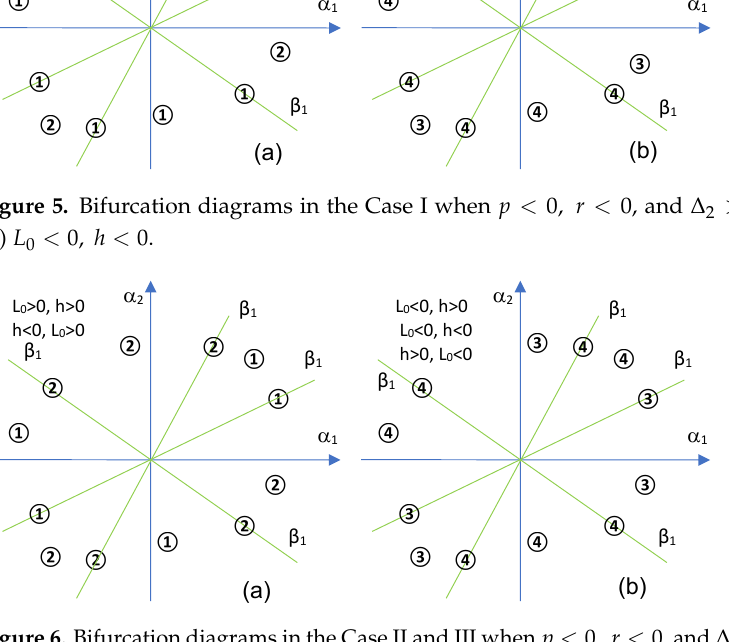
Figure 6. Bifurcation diagrams in the Case II and III when p < 0, r < 0, and ∆ 2 > 0: ( a ) L 0 > 0, h > 0 or h < 0, L 0 > 0; ( b ) L 0 < 0, h > 0 or L 0 < 0, h < 0 or h > 0, L 0 < 0.